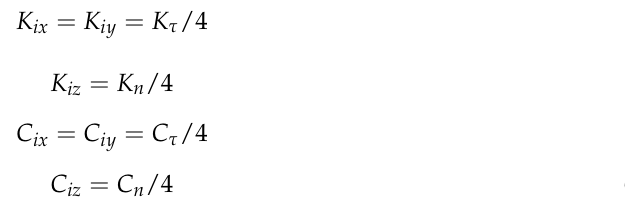
Figure 3a. At each node, there are three sets of spring damping units. The normal and tangential total sti ff ness and damping of the spring are the normal and tangential total sti ff ness and damping of the joint, respectively. The value of each spring and damping can be expressed, respectively, as: